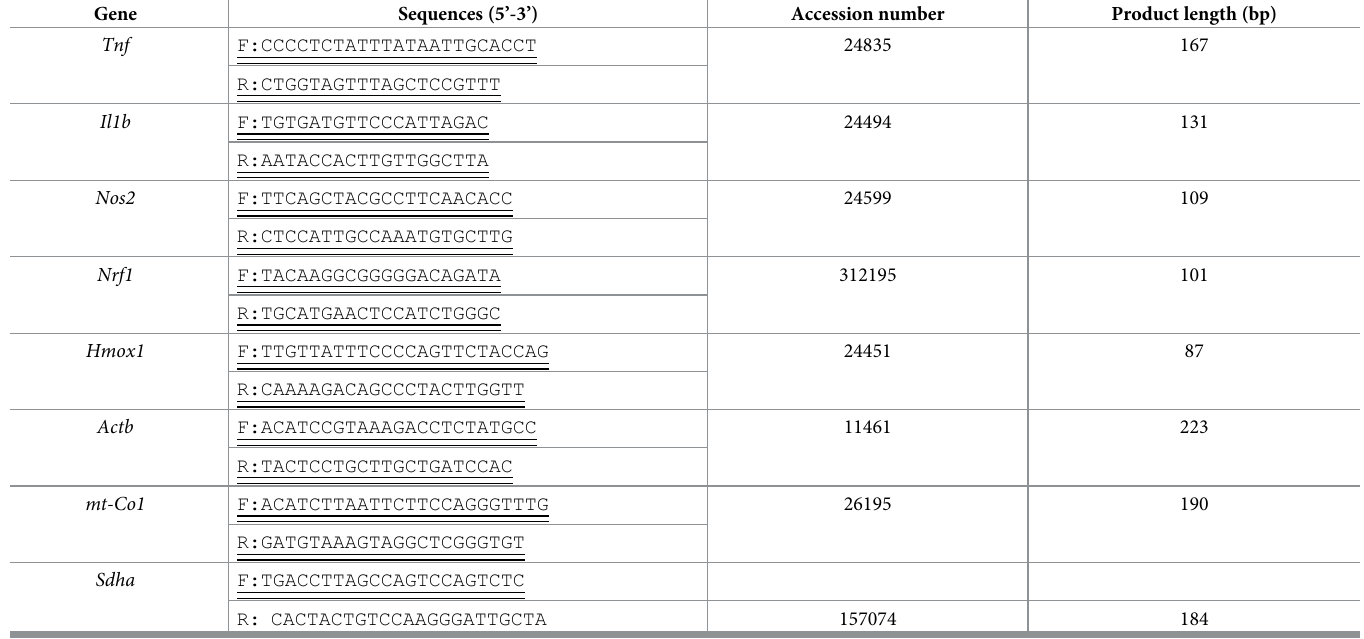
Table 2. Primer sequences used for qRT-PCR. Gene Sequences